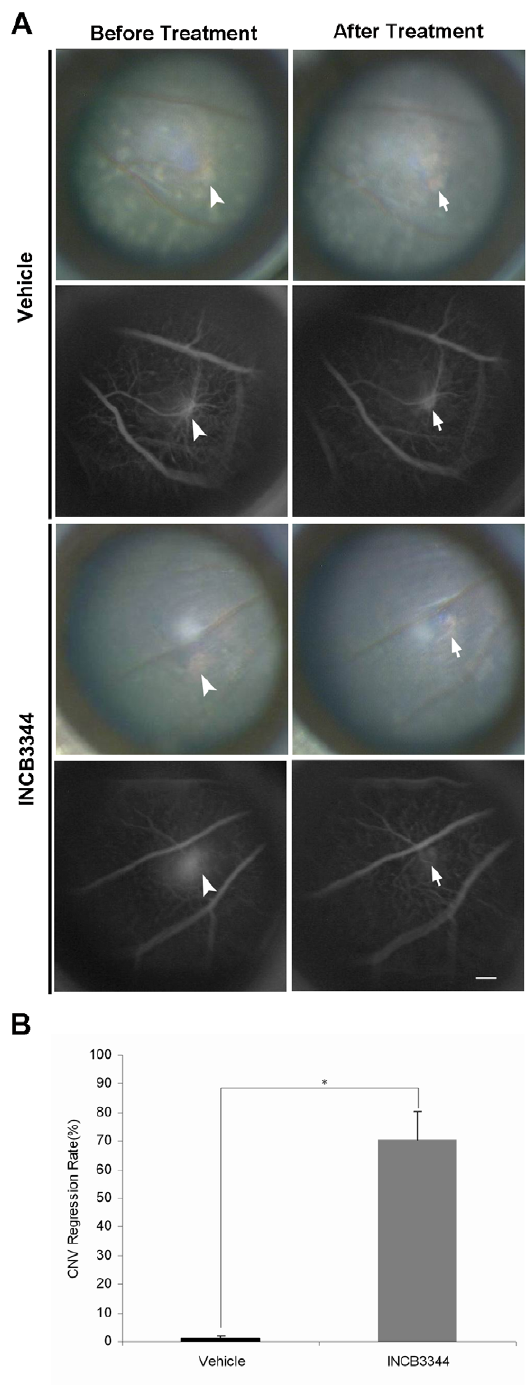
Figure 5. Effect of INCB3344 on established CNV. ( A ) Fundus photographs (1 st and 3 rd rows) and fluorescent angiography (2 nd and 4 th rows) pre-treatment (1 st column) and post-treatment (2 nd column) with vehicle (top 2 rows) or INCB3344 (bottom 2 rows). Established CNV in Sod1 2 / 2 mice were markedly regressed by INCB3344 treatment (bottom), while no significant regression of established CNV was detected in vehicle treatment (top). Scale bar=20 m m. ( B ) INCB3344 treatment caused a 70.35 6 9.86% decrease ( n =6) in established CNV size, which was significantly higher than that in vehicle treatment (1.0 6 1.0%, n =7, * P ,